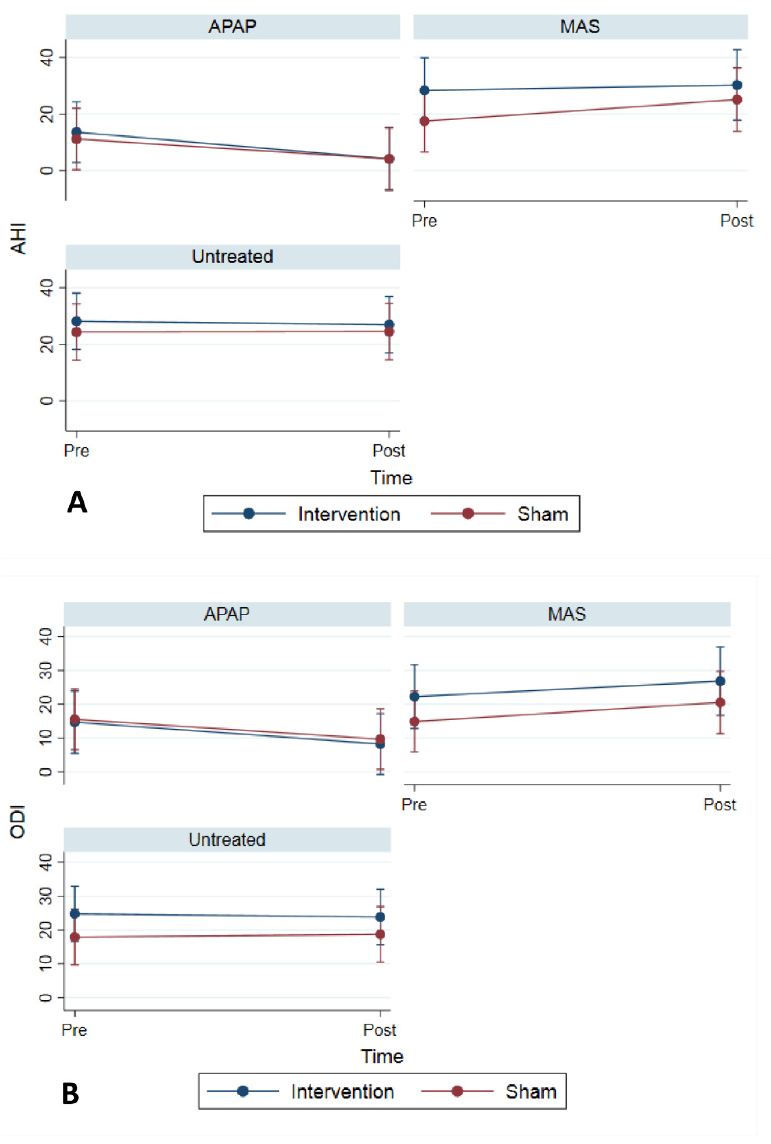
Figure 3. ( A ) Change in Apnea Hypopnea Index (AHI) across treatment groups. ( B ) Change in Oxygen Desaturation Index (ODI) across treatment groups.